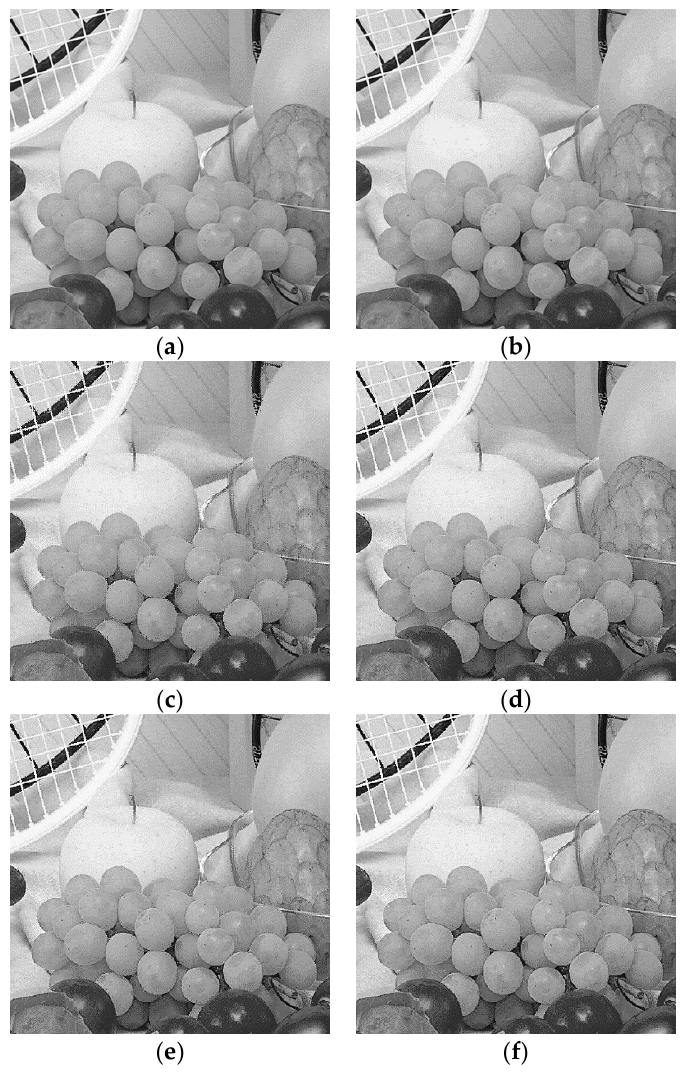
Figure 13. Visual investigation on Image Set 1 with quality factor 𝑄 = 10 : ( a ) input image; ( b ) JPEG decoded image; ( c ) ODBTC; ( d ) EDBTC; ( e ) DDBTC; and ( f ) DDBTC Gaussian method.